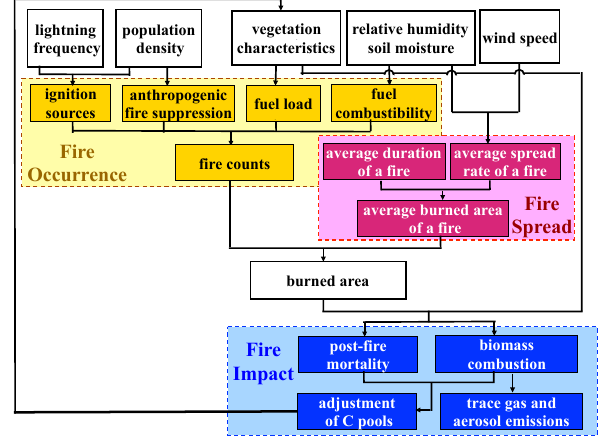
Fig. 1. Fire parameterization of Li et al. (2012a, b). It contains three components: fire occurrence, fire spread, and fire